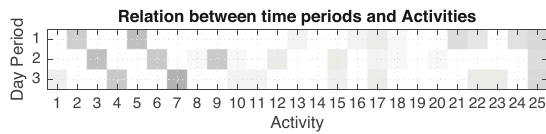
Figure 7. Relation between periods of the day (1: Morning; 2: Noon, 3: Afternoon) with the